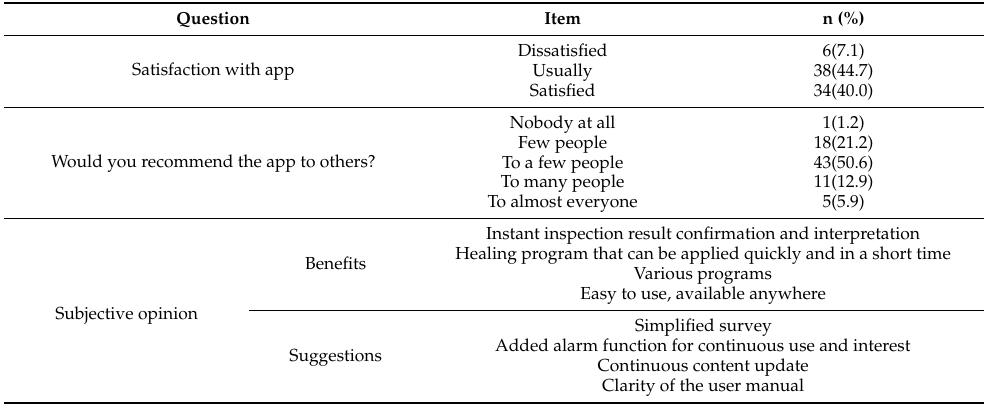
Table 4. Satisfaction of Mental Health Mobile App (N =